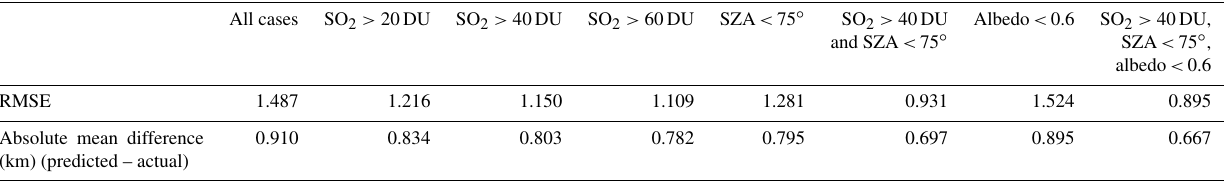
Table 3. The RMSE and the mean absolute difference of all data points in the test set under different conditions. For each condition, the appropriate points were removed and excluded in error calculations. All cases in this table used synthetic training spectra with added SNR 1000.